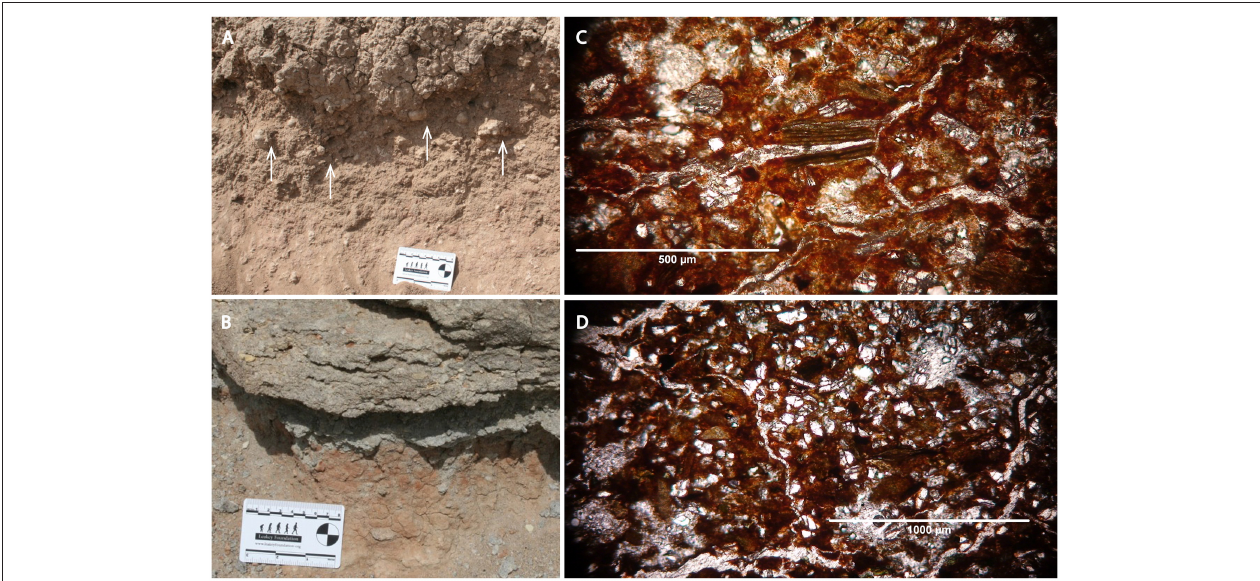
FIGURE 7 | Features of the silty claystone facies, including carbonate nodules (shown by arrows in A ) and Krotovina-like structures (B) . Thin root traces (C) and plant microfossils (D) are abundant in thin section (plane light).